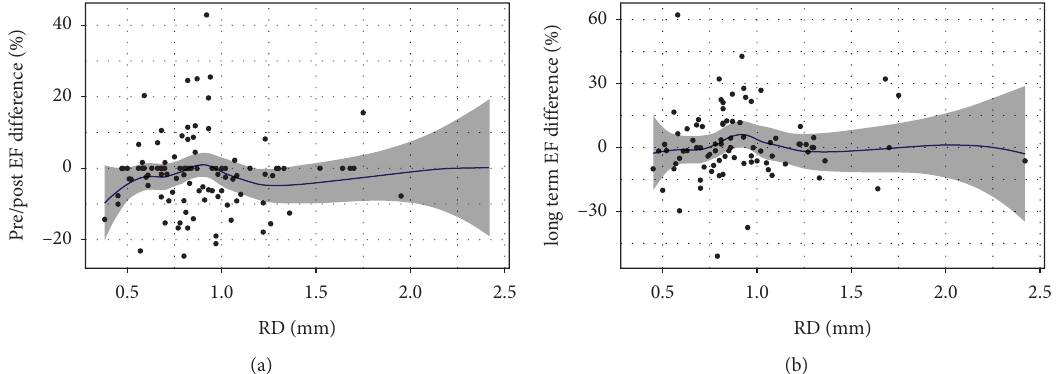
Figure 5: (a) Scatter plot of the reference diameter (RD) and creatinine kinase (CK); (b) scatter plot of the RD and ejection fraction (EF) change from the baseline to follow-up.